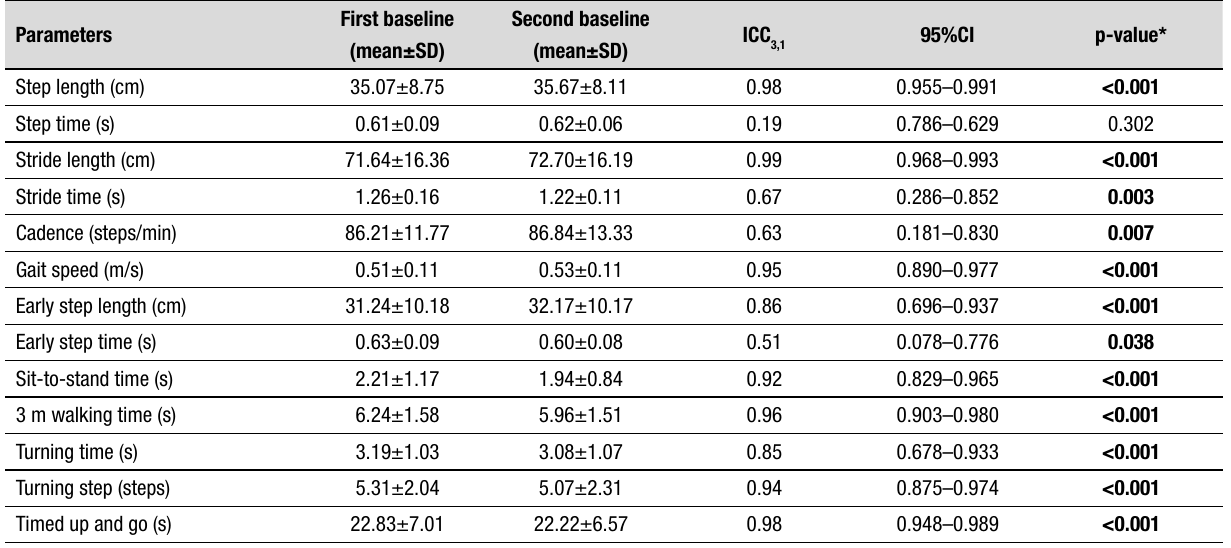
Table 2. Test-retest reliability of gait and mobility parameters between the first and second baseline measurements. Parameters